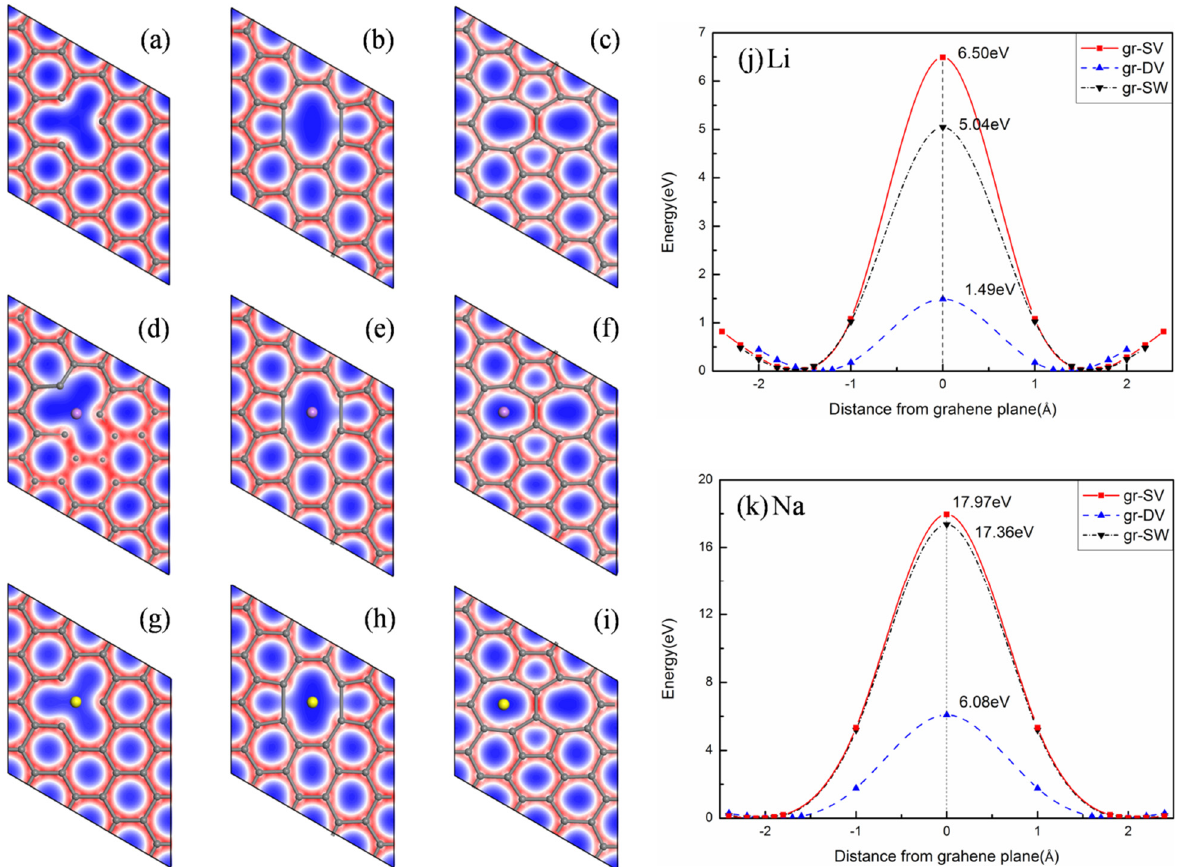
Figure 2. Distribution of the total electronic charge density for defected graphene: ( a ) single vacancy (SV); ( b ) double vacancy (DV); ( c ) Stone–Wales (SW); ( d ) SV with Li; ( e ) DV with Li; ( f ) SW with Li; ( g ) SV with Na; ( h ) DV with Na; ( i ) SW with Na; ( j ) and ( k ) corresponding diffusion barriers for Li and Na.